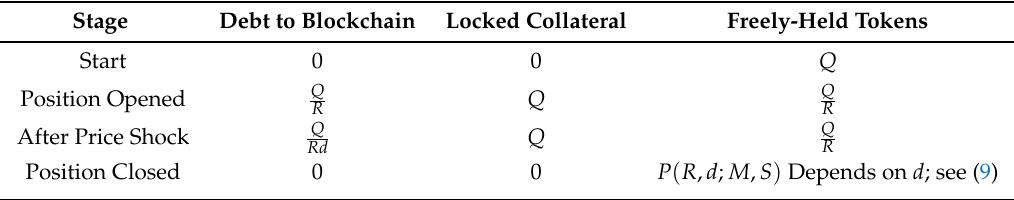
Table 1. Tabular depiction of collateralization incentive model. In the first row, labeled Start , the agent holds Q core blockchain tokens, no debt, and no collateral. In stage 2, the agent has committed Q tokens as collateral and received a loan of Q / R price-stable tokens, which are then sold. In stage 3, the value of the core token has changed by a factor of d ; since our accounting is being done in core tokens, the effect of this is that the agent’s debt is modified by a factor of 1/ d . In stage 4, the debt position is closed, resulting in either a profit or a loss for the agent depending on the M and S